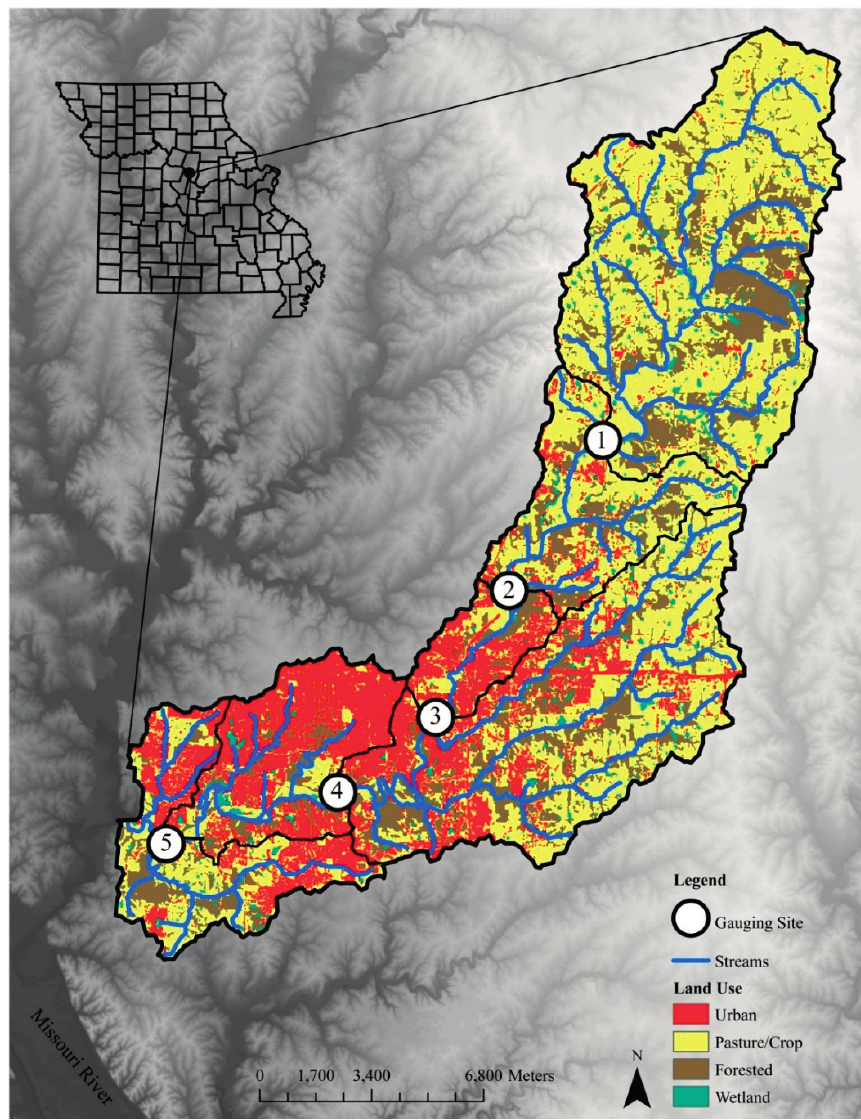
Figure 1. Location of gauging sites ( n = 5) and respective sub-basins in the Hinkson Creek Watershed, central Missouri,